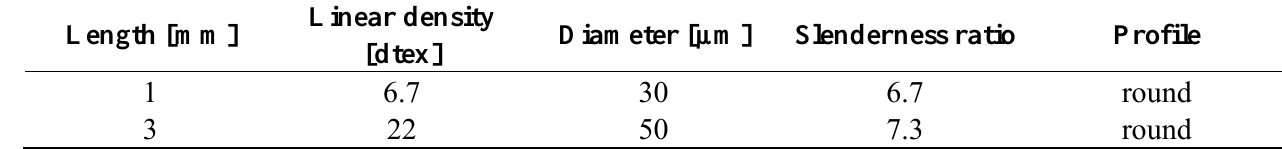
Table 3. Properties of polyamide